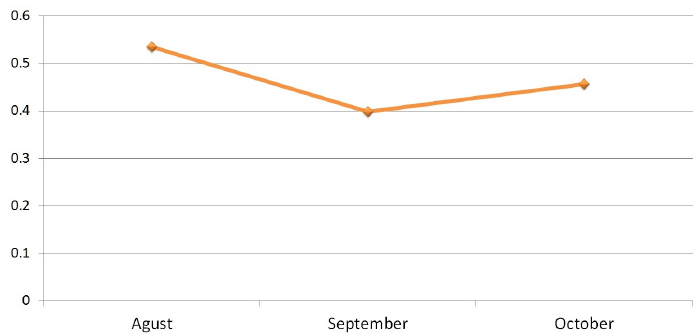
Figure 13. The trend of the prediction from August to October is similar to the result presented in